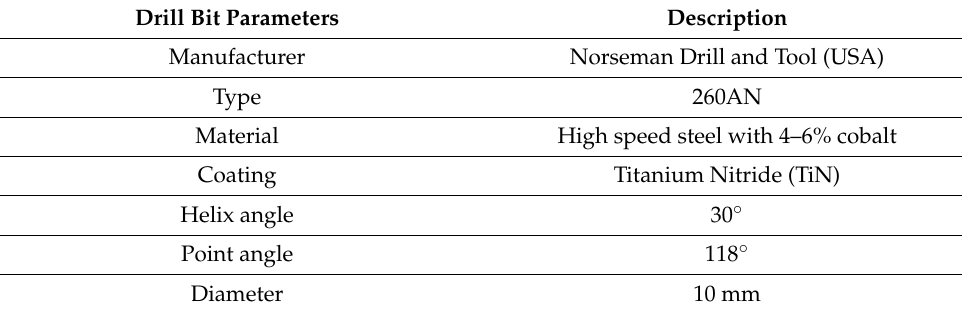
Table 5. Drill bit material and geometric descriptions.